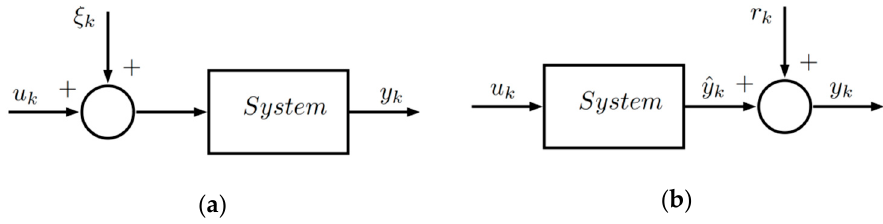
Figure 1. Single-input and single-output (SISO) system: ( a ) With white noise to the input; ( b ) With additive noise to the output.